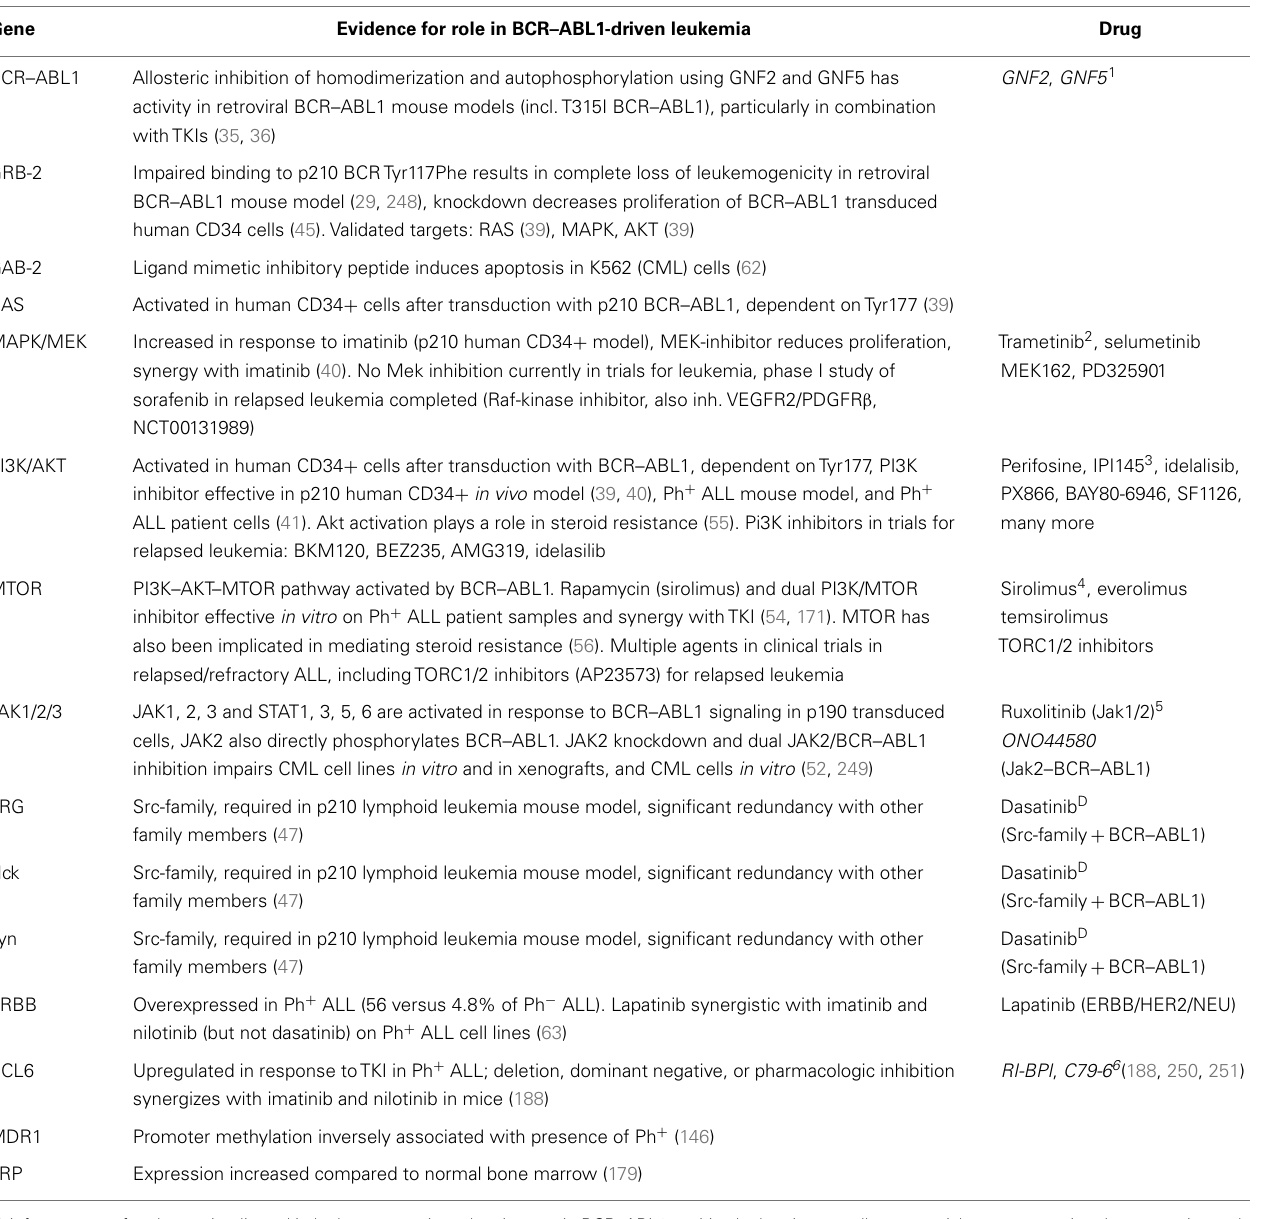
Table 1 | BCR–ABL1 downstream and parallel pathways as drug targets